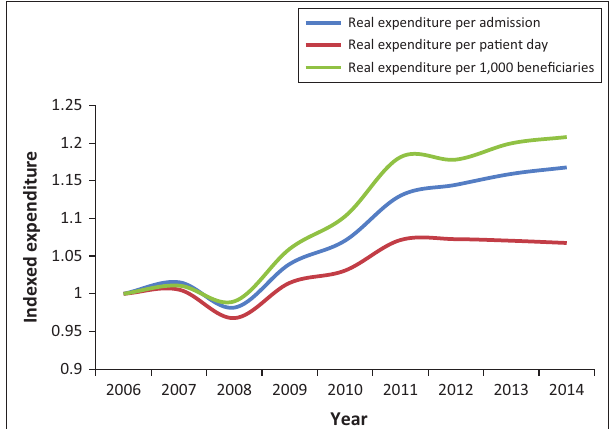
FIGURE 4: Cumulative indexed increase in real expenditure at three hospital groups per 1000 beneficiaries, per admission and per day; 2006–2014 (2006 =